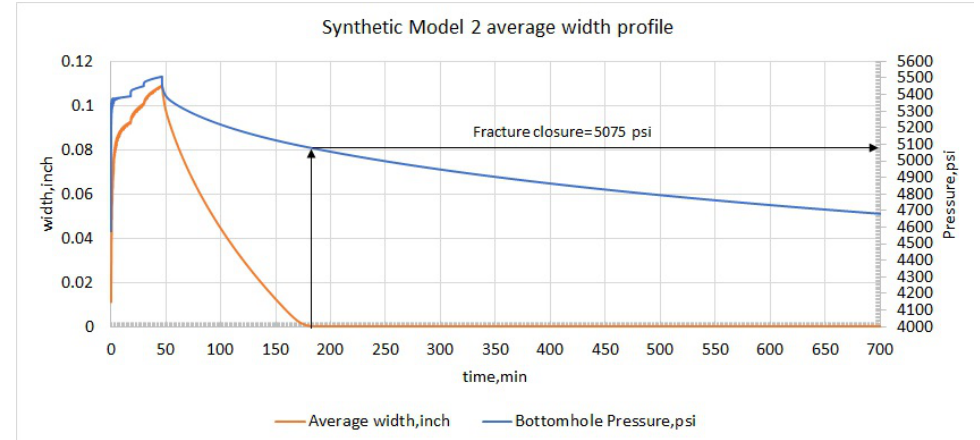
Figure 13. Average width profile for synthetic model 2.